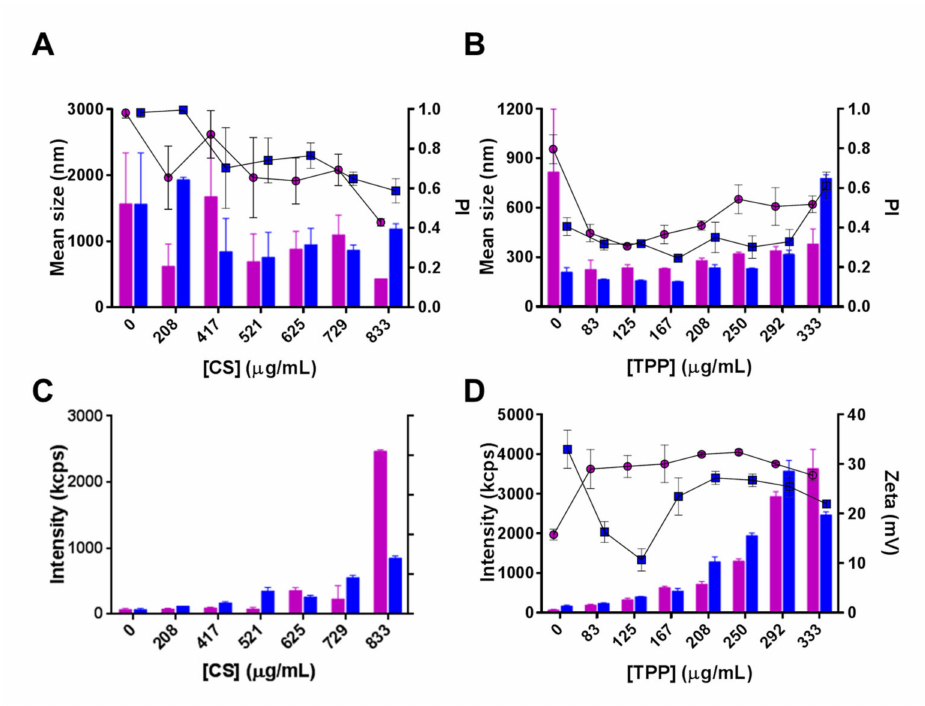
Figure 4. Effect of chitosan (CS) and tripolyphosphate (TPP) concentration on the characteristics of nanoparticles loaded with human phenylalanine hydroxylase (hPAH) at a final concentration of 55 µ g/mL. ( A , B ) Mean size (bars) and PI (lines) at pH 5.5 (pink) and 6.0 (blue), as monitored by DLS. ( C , D ) Nanoparticle yield by intensity of diffracted light by dynamic light scattering (DLS) (bars) and zeta potential (lines) at pH 5.5 (pink) and 6.0 (blue). Values represent mean ± S.D ( n = 3). For further details see Materials and